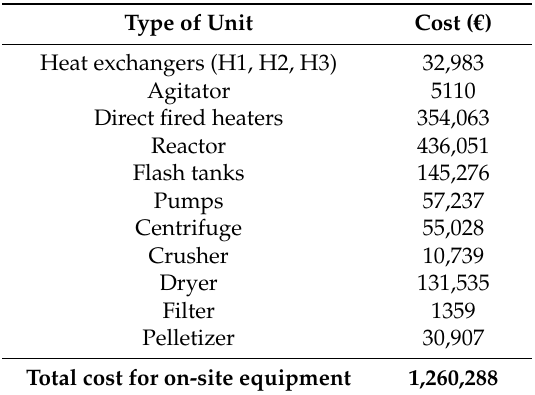
Table 4. Capital cost estimate of bare-module equipment for the HTC